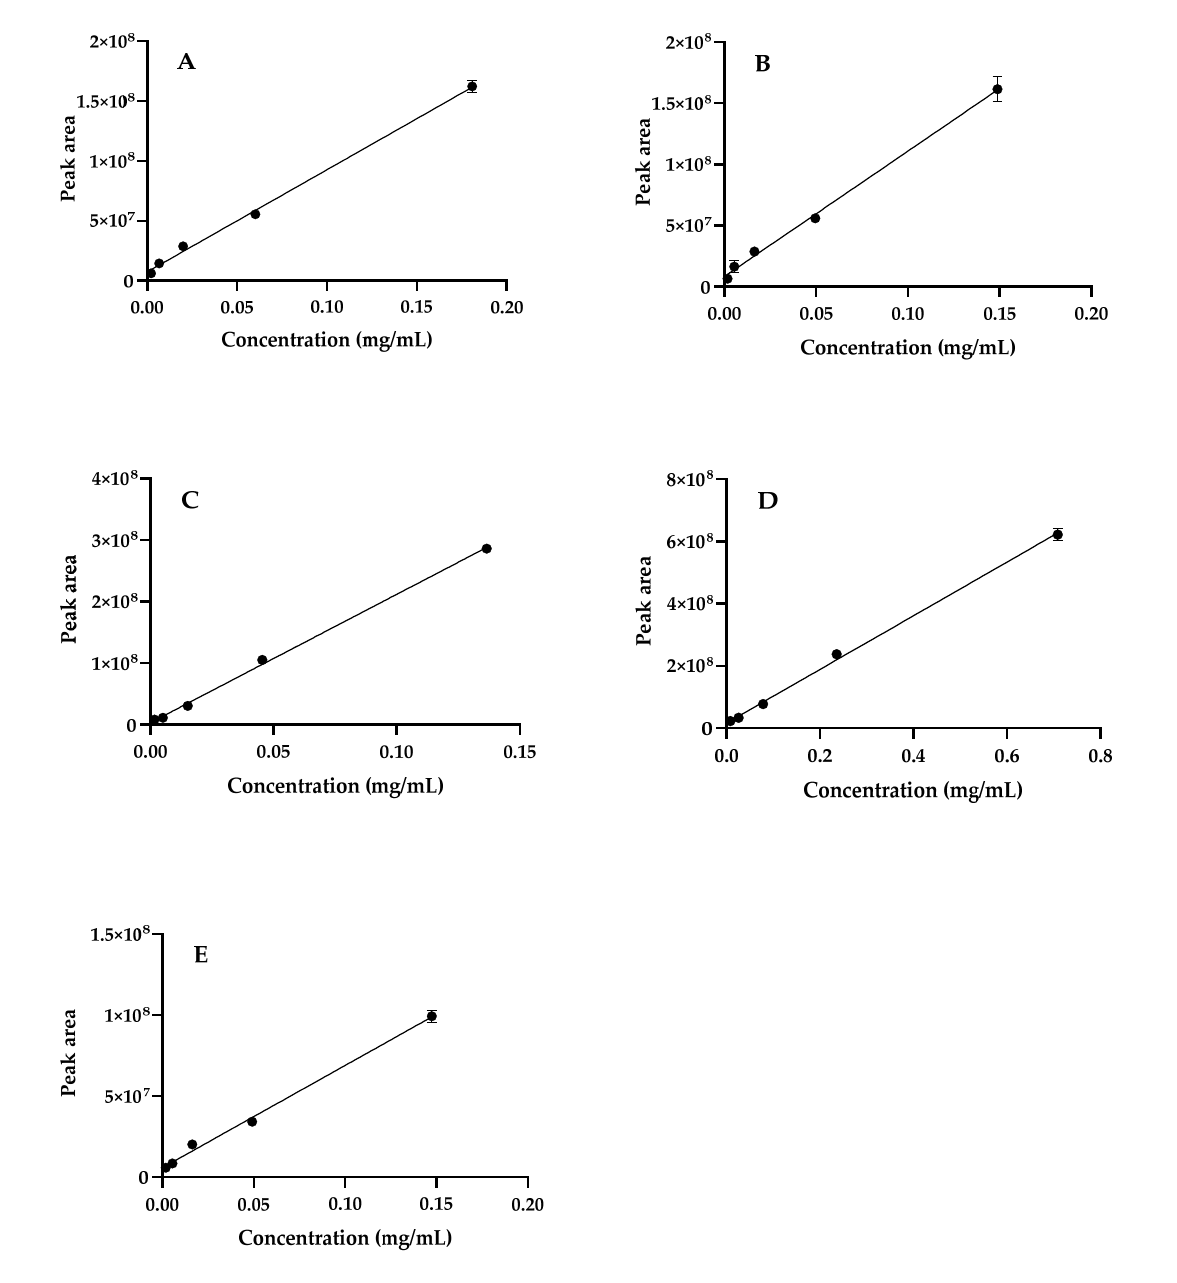
Figure 5. Calibration curves of ( A ) 4- O -ca ff eoylquinic acid; ( B ) chlorogenic acid; ( C ) ca ff eic acid; ( D ) rosmarinic acid; ( E ) kaempferol-3- O -rutinoside; Regression equation and r 2 values are presented in Table 1. Results are expressed as mean ± SD of three independent analysis.